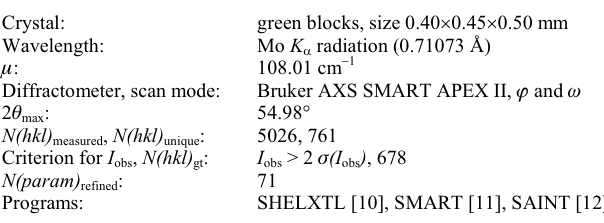
Table 1. Data collection and